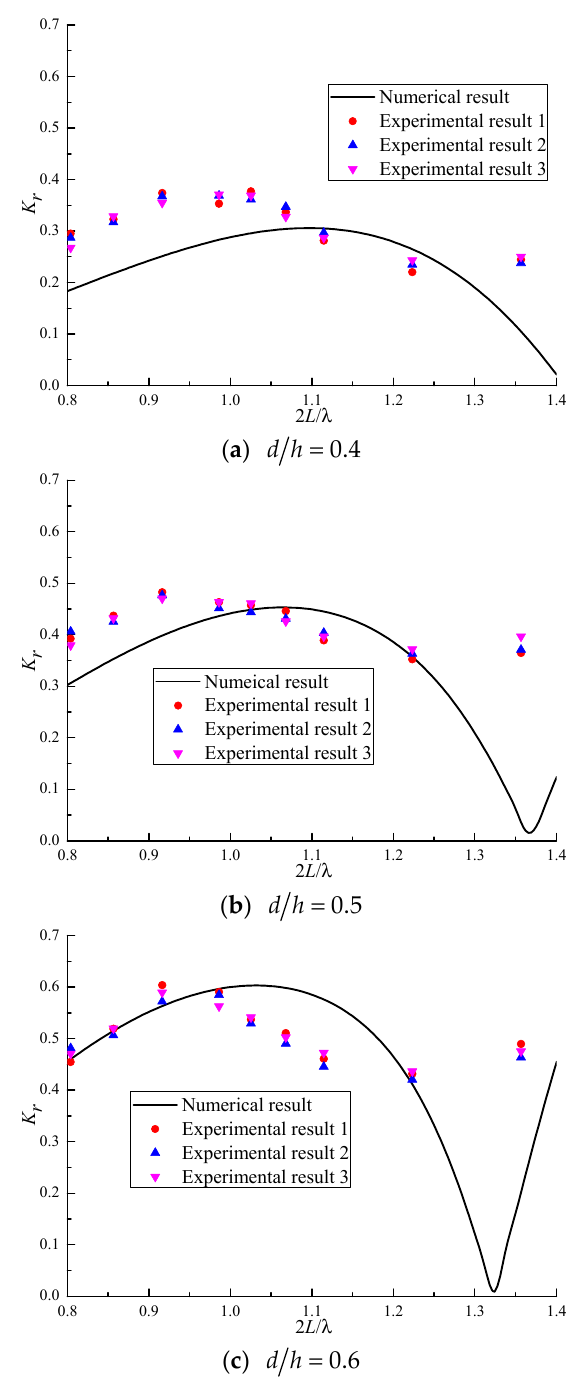
Figure 12. Comparisons of the numerical and experimental reflection coefficients ( N = 2 and L / h =